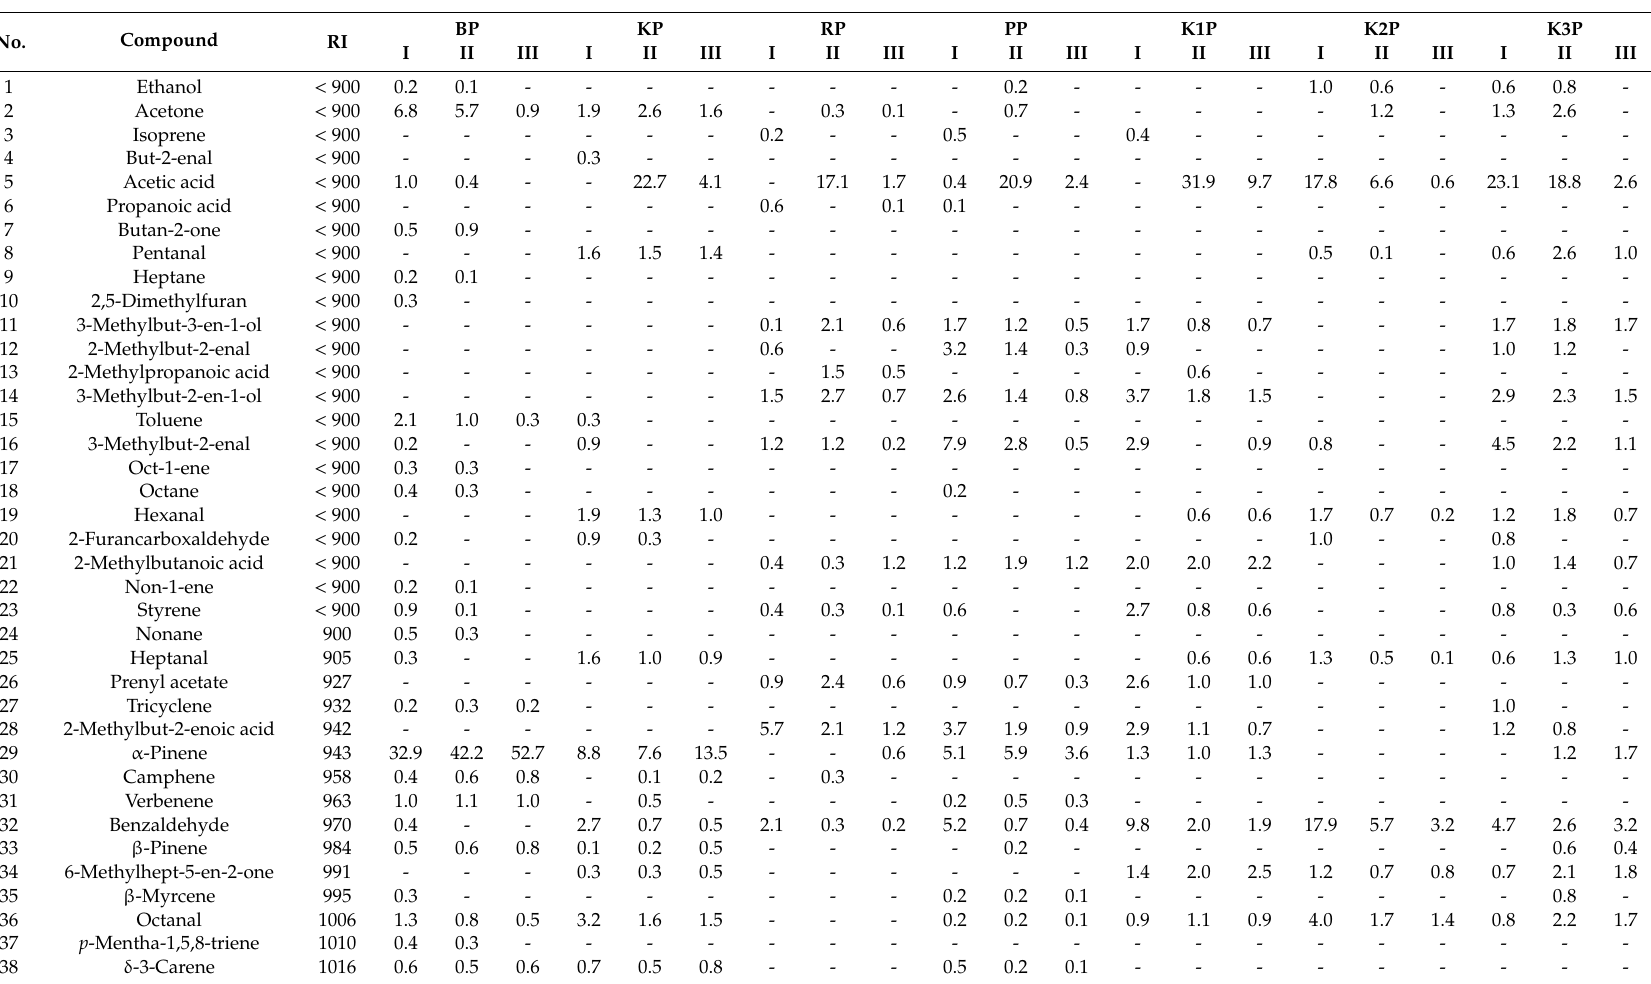
Table 1. Volatiles determined by headspace solid-phase microextraction (HS-SPME) / gas chromatography